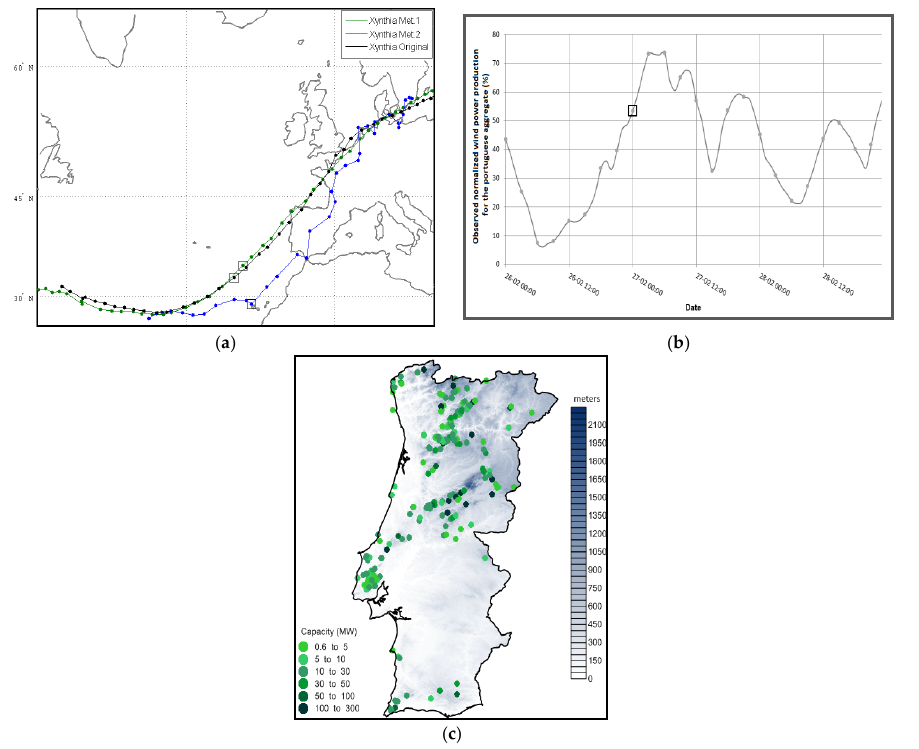
Figure 1. ( a ) Resulting trajectories for Xynthia storm with: Methodology 1 (green), Methodology 2 (blue), Original (black) [43]; ( b ) Observed normalized wind power production for the portuguese aggregate during the days 26 to 28 of February 2010. The black square marker represents the time step 27/02/2010 00:00 [3]; ( c ) Orography and wind park distribution over continental Portugal discerned by nominal power capacity [44,45].